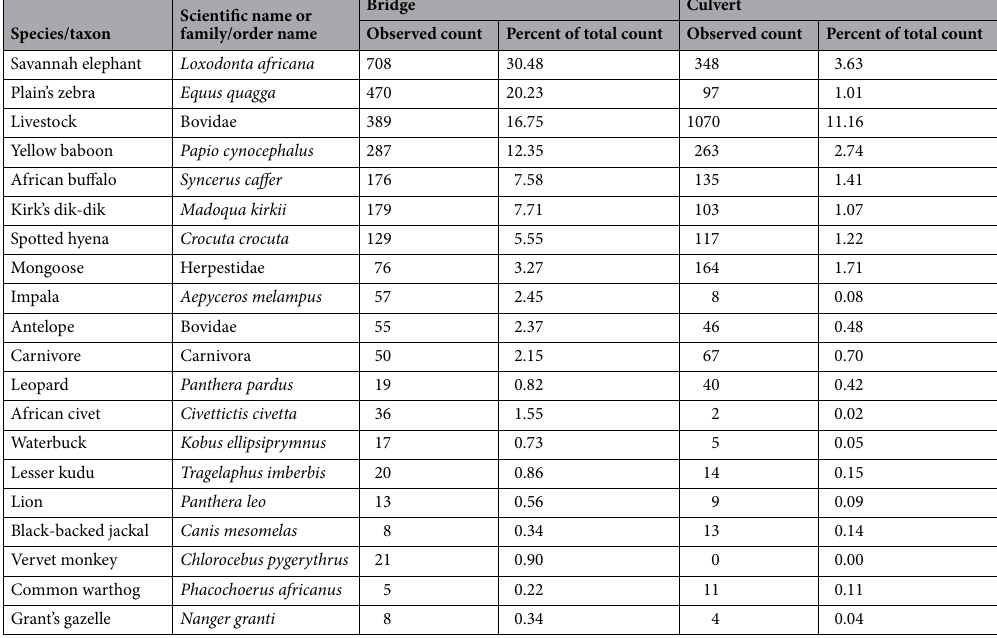
Table 1. The frequency and percentage use of underpass by medium- to large-sized mammals in the Tsavo Conservation Area ranked by observed bridge